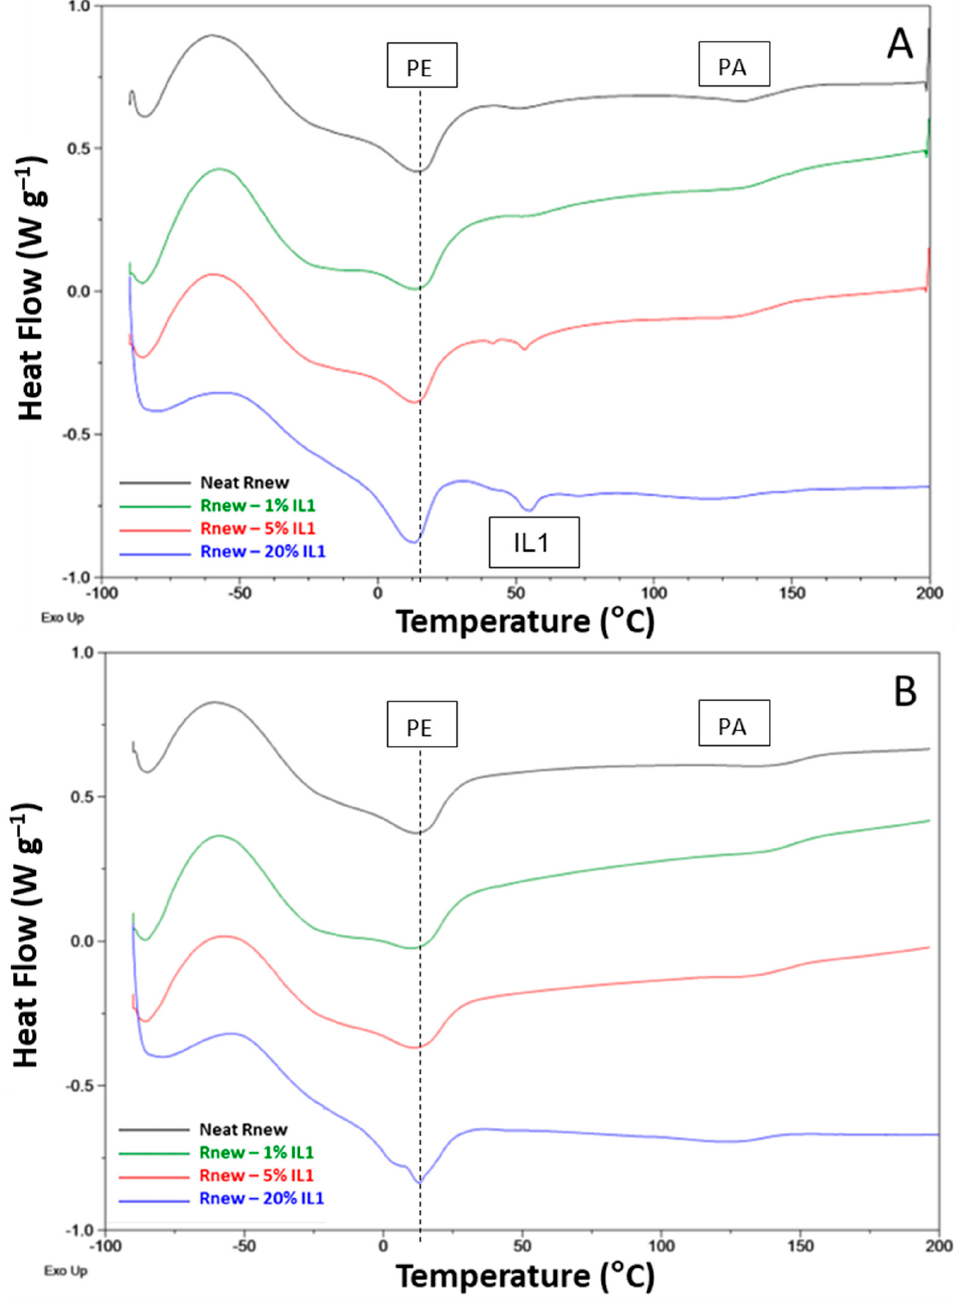
Figure 6. DSC traces for neat Pebax ® Rnew and Pebax ® Rnew–IL1 (HdmimDMSIP) composite mem- branes. ( A ) First heating scan; ( B ) Second heating scan.